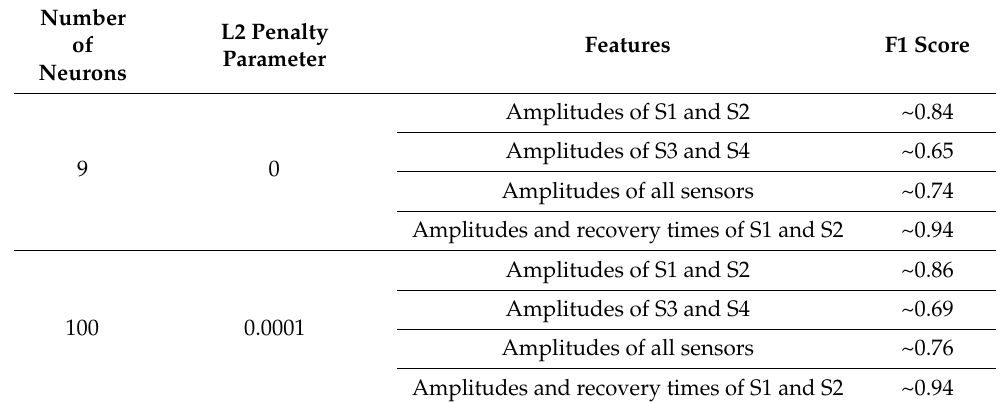
Table 3. Prediction accuracy of a trained ANN model (using the indicated features), when applied to the test data.